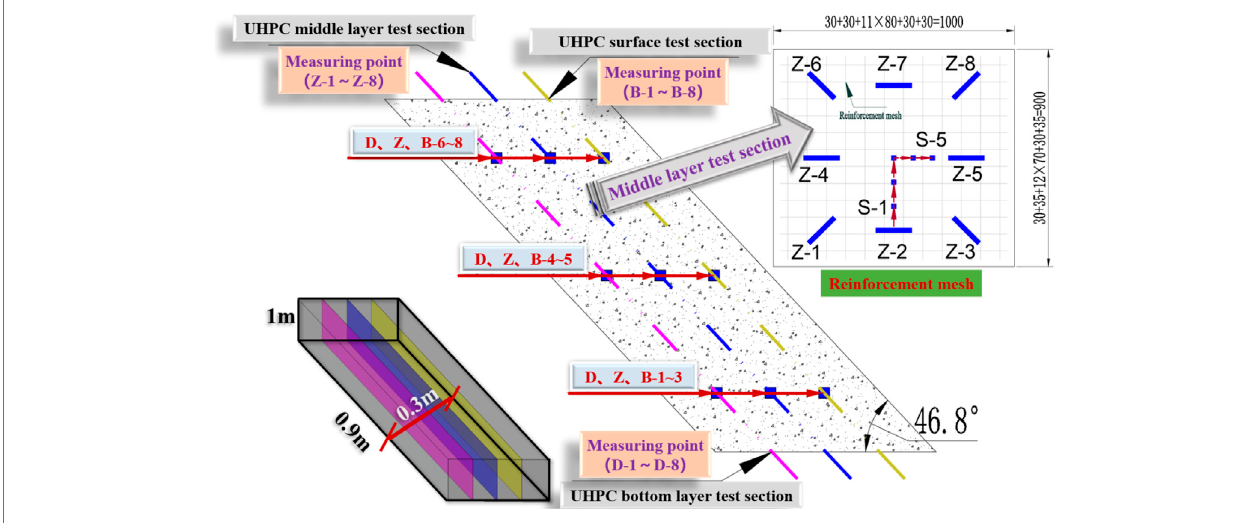
FIGURE 7 | Arrangement of the measurement points.